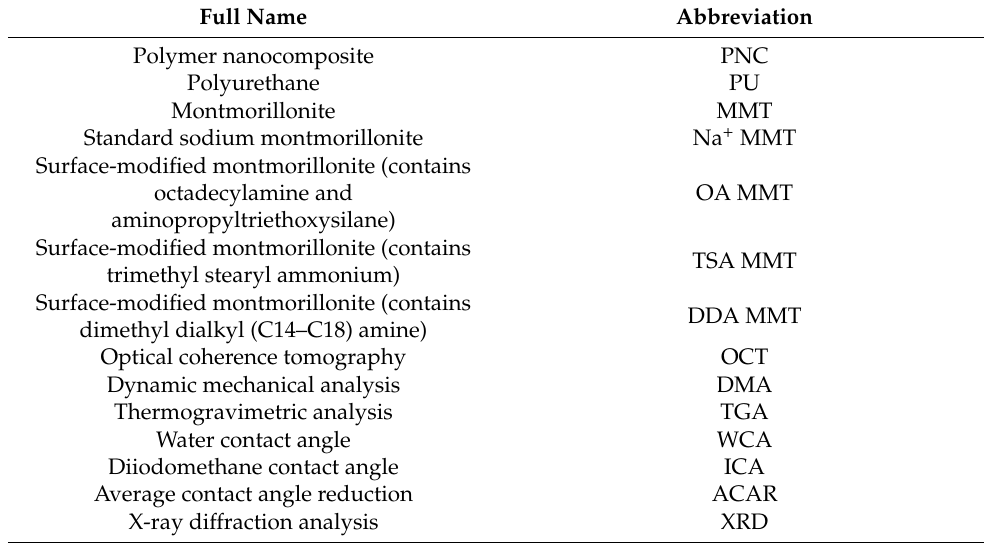
Table 1. List of key